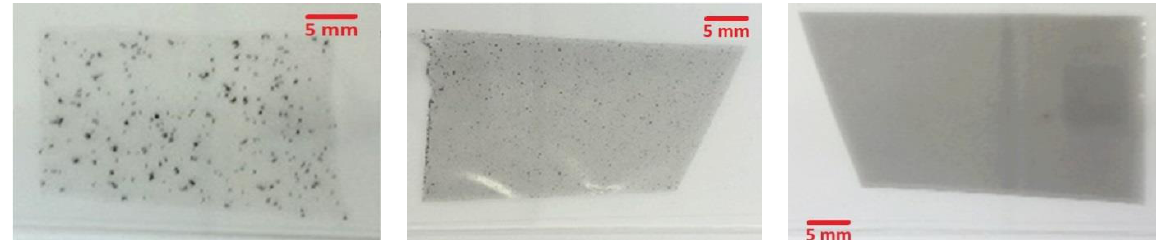
Figure 4. Dried films from preliminary study, without any secondary dispersion step. Left : 2.5 wt.% cellulose acetate (CA) solution (low viscosity), middle : 5 wt.% CA solution, right : 10 wt.% CA solution.